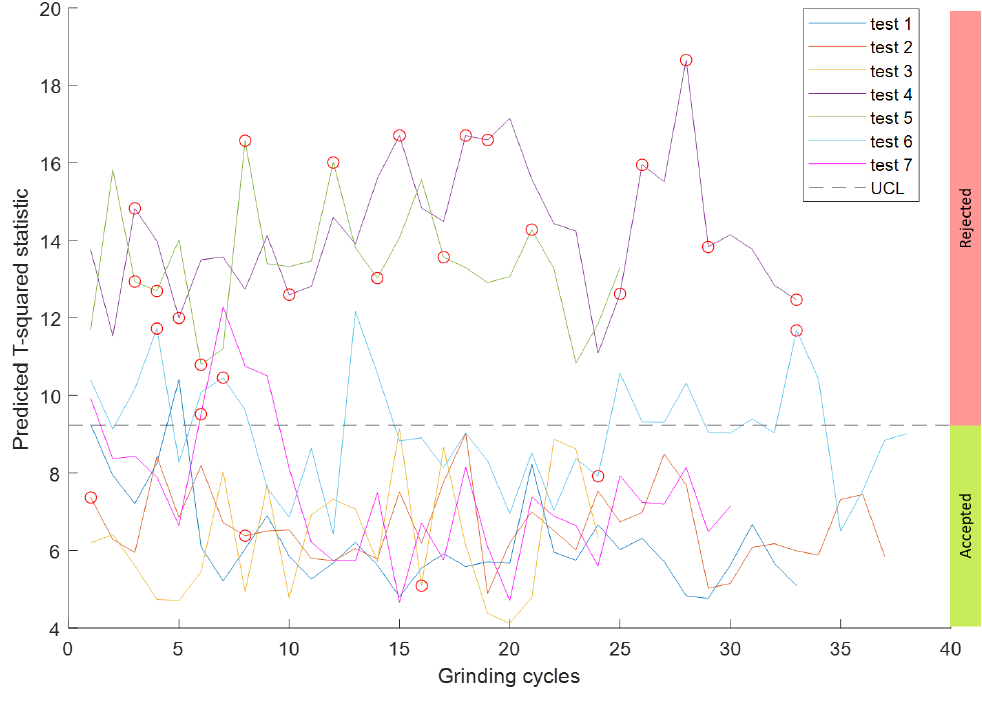
Figure 14. Predicting the overall produced quality in test data through estimating T 2 statistic. The dashed line represents Upper Control Limit threshold above which the quality is unacceptable. The red circle markers indicate the rejected rings according to quality